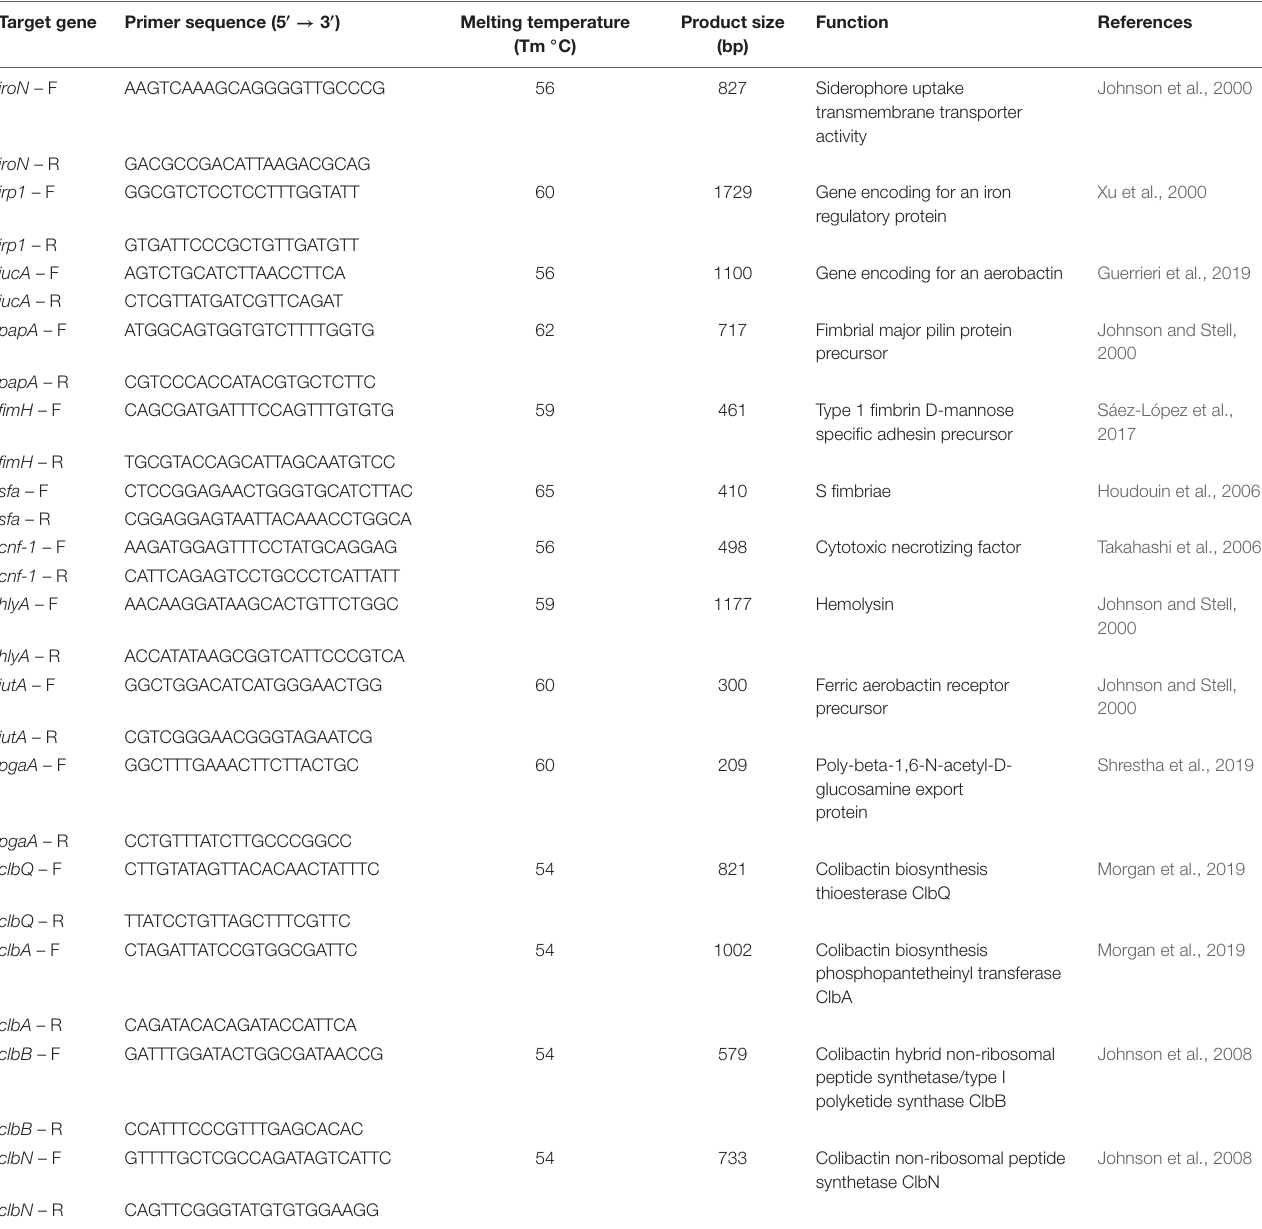
TABLE 2 | Primers to detect virulence factor genes. Target gene Primer sequence (5 (cid:48) → 3 (cid:48)